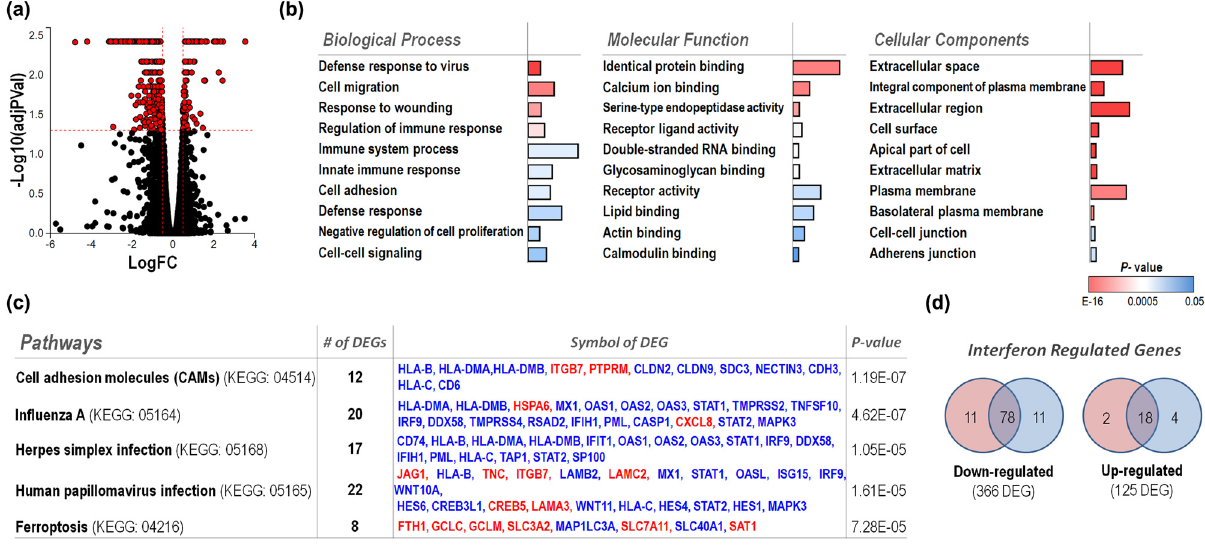
Figure 3: Compound 1 promoted a distinctive transcriptomic change in HT - 29 cells with signi fi cant e ff ect on genes associated with cell survival and proliferation; response to virus; and ferroptosis. ( a ) The mRNA expression changes of HT - 29 treated with 1 ( 1.73 μ M ) compared with the control are presented using a volcano plot constructed in iPathwayGuide. Positive values on the x - axis indicate up - regulation, whereas negative values indicate down - regulation, both presented as Log2 fold change ( LogFC ) . The y - axis represents a log scale showing the adjusted p - value. Red dots ( 491 ) represent di ff erentially expressed genes ( DEGs ) . ( b ) GO analysis was performed with iPathwayGuide; cut - o ff p - value, p < 0.05, using weight pruning correction. Enrichment signi fi cance is displayed as bar color intensity while its height is proportional to the number of DEGs in the GO term. ( c ) The top fi ve signi fi cant impacted pathways by compound 1 as categorized by iPathwayGuide, p - values are shown without correction. DEGs are highlighted in red when up - regulated or blue when down - regulated. ( d ) Interferome database was employed to identify the number of IRGs – type I ( red ) and type II ( blue ) – in the list of